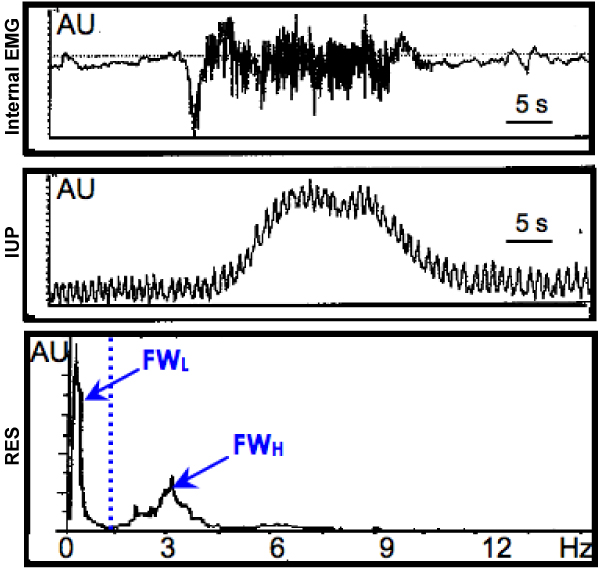
Characteristics of the Uterine EMG. Uterine EMG (internal electrodes) recorded on a pregnant cynomolgus monkey during pregnancy (upper trace), related Intra Uterine Pressure (middle trace) and Relative Energy Spectrum (RES) (lower trace). FWL and FWH, fast wave low and fast wave high, are the main components of the relative energy spectrum (RES), respectively. AU, arbitrary units.